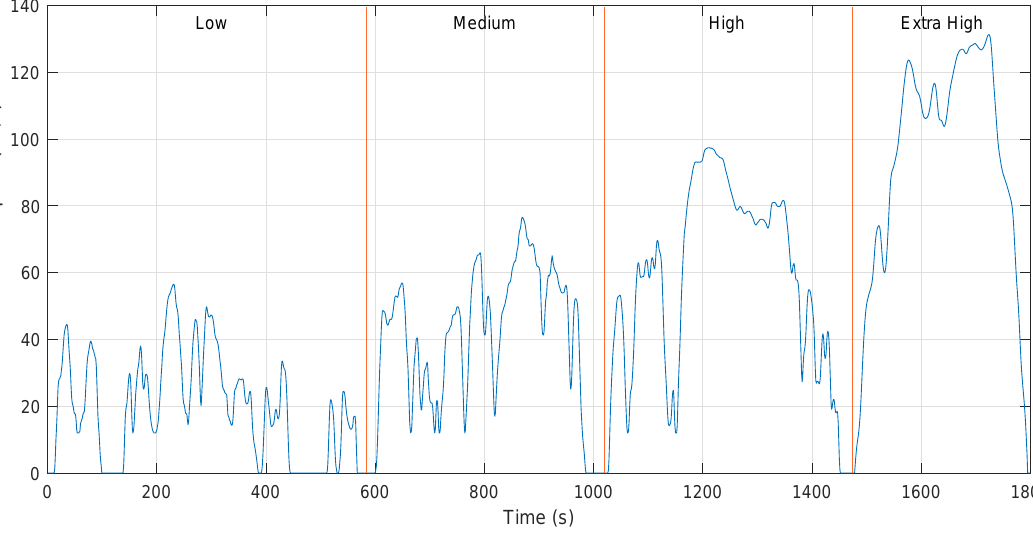
Figure 8. Class 3b Worldwide harmonized Light vehicle Test Procedure (WLTP) test cycle. Table 4. Statistical data of Class 3B WLTP cycle with a total of 1800 s and 23.266